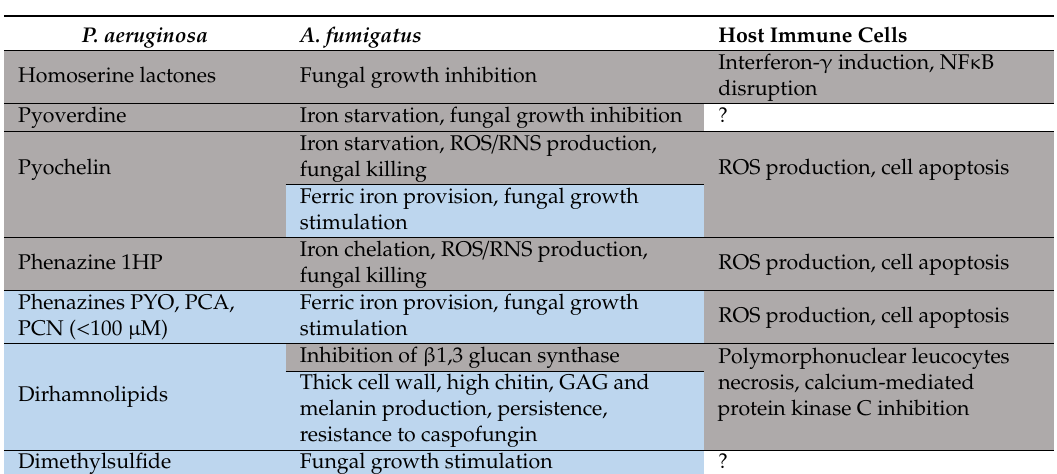
Table 2. Bacteria– A. fumigatus –host interactions. E ff ect of P. aeruginosa molecules on A. fumigatus and host immune cells. In grey, antifungal and anti-host cell activity by P. aeruginosa molecules; in blue, stimulation of A. fumigatus growth by P. aeruginosa